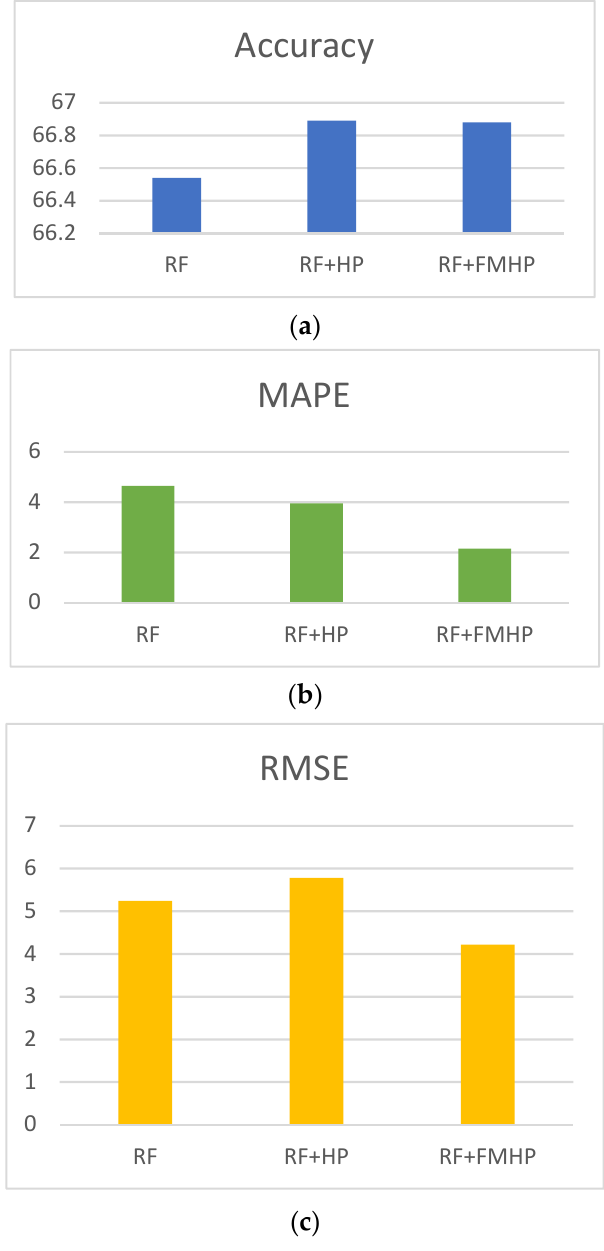
Figure 7. Performance of random forests in predicting the closing price of AAPL ( a ) prediction accuracy, ( b ) MAPE, and ( c ) RMSE.